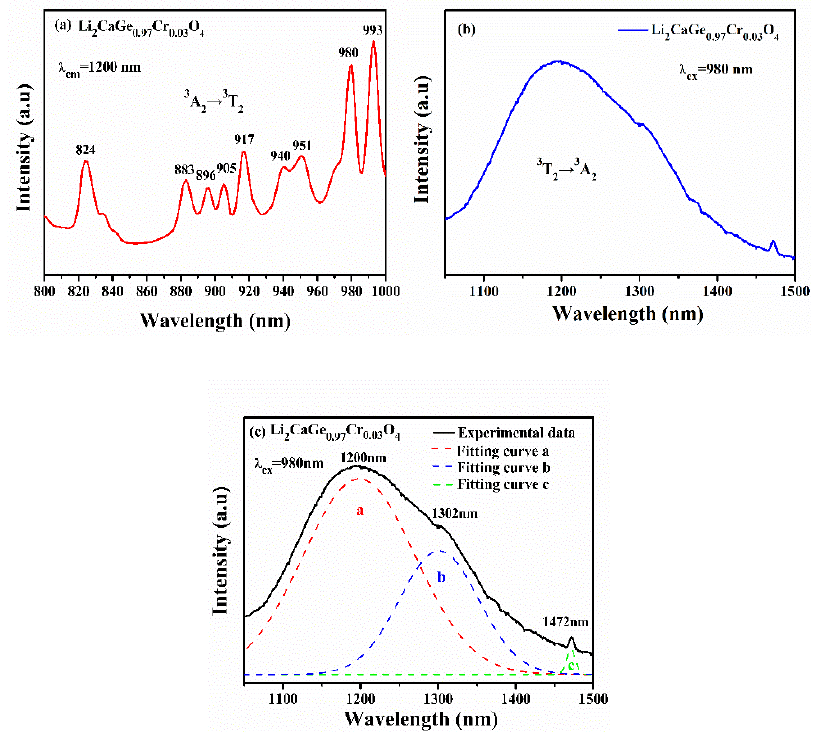
Figure 6. ( a ) Excitation spectra of Li 2 CaGe 0.97 Cr 0.03 O 4 ( λ em = 1200 nm); ( b ) emission spectra of Li 2 CaGe 0.97 Cr 0.03 O 4 ( λ ex = 980 nm); ( c ) Gaussian-fitted spectrum of the emission spectra of Li 2 CaGe 0.97 Cr 0.03 O 4 ( λ ex = 980 nm).